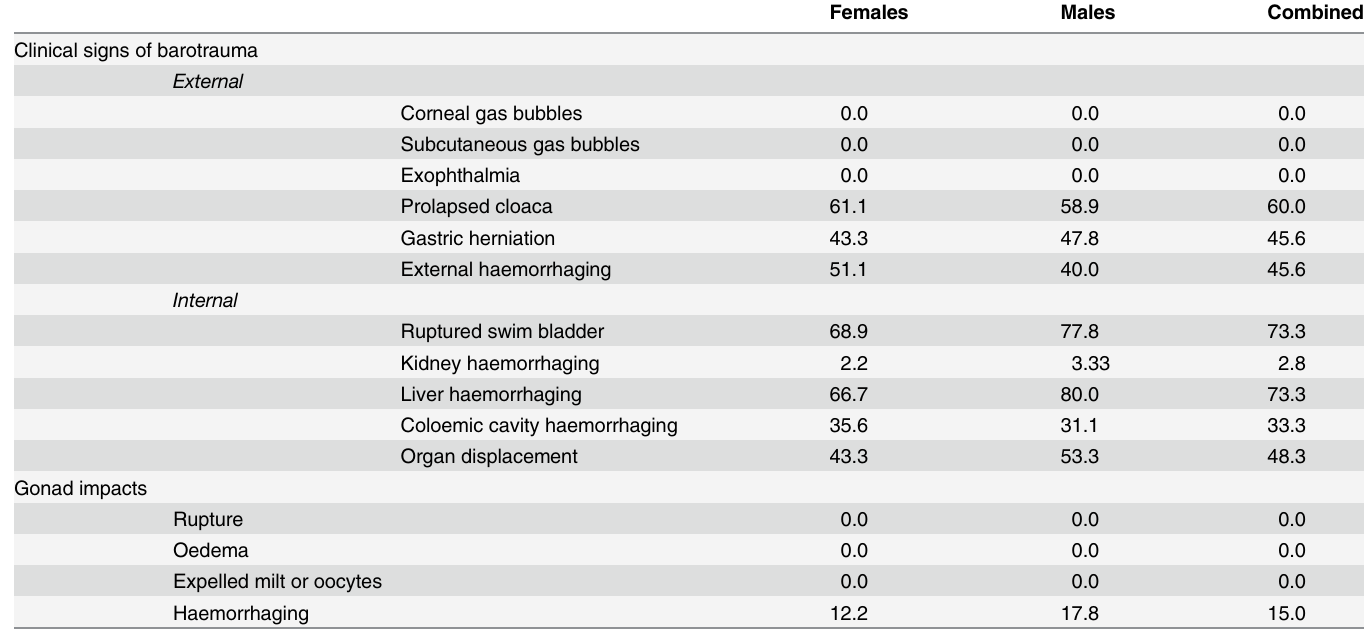
Table 1. Percentage occurrence of dichotomous internal and external clinical signs of barotrauma and impacts to gonads observed for 90 female (mean TL ± SD of 48.92 ± 13.10 cm) and 90 male (mean TL ± SD of 48.71 ± 11.74 cm) Chrysophrys auratus (and both sexes combined) angled from 8.0-63.7 m off New South Wales during four months from 8 June